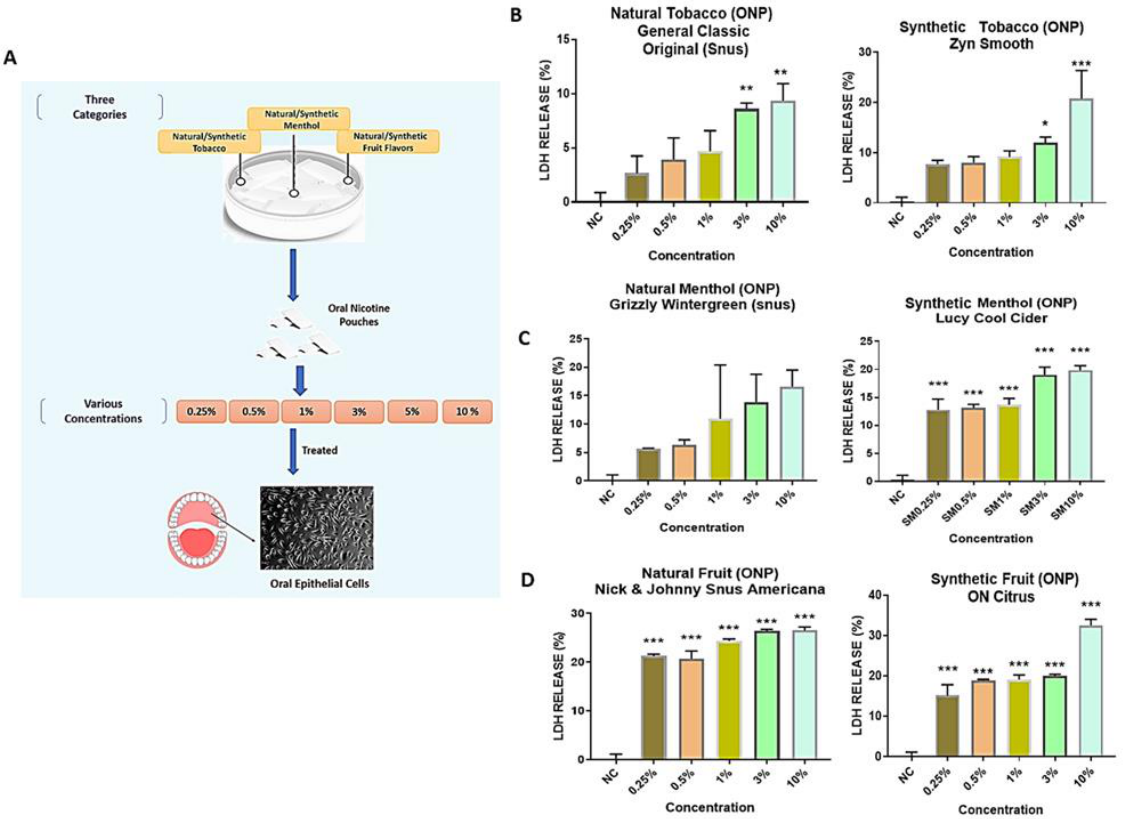
Figure 3. Differential cytotoxicity among oral epithelial cells upon treatment with different flavored oral smokeless nicotine products : ( A ) Diagrammatical representation of the experimental workflow. (B – D) Cytotoxicity Assay on oral epithelial cells: human gingival epithelium progenitors cells (HGEPp; gingival epithelial cells) were treated with different doses (0.25%, 0.5%, 1%, 3%, and 10%) of oral nicotine extracts categorizing natural/synthetic tobacco, menthol, and fruit flavors from different brands (Snus, Zyn, Grizzly, Lucy and ON). Followed by 24 h exposure, conditioned media were used for the lactate dehydrogenase (LDH) assay. Data represented as mean ± SEM, * p < 0.05, ** p < 0.01, *** p < 0.001 compared to control. n = 3. 3.1.2. Cytotoxicity of BEAS-2B Cells were Exposed to Different Concentrations of Ex- tracts Isolated from Spearmint-Flavored Snus (SKOAL) and ONPs (Zyn) BEAS-2B cells were exposed to different concentrations of extracts isolated from spearmint-flavored snus (SKOAL) and ONPs (Zyn). Subsequently, the cytotoxicity of the flavored nicotine ouches was assessed through collecting culture media exposed to 24 h of treatment with a respective extract. The untreated group was considered the control group. Among the tested spearmint products, minimal LDH release was observed at 0.05% concentration, whereas exposure to the 0.1% and 0.25% concentrations exhibited significant levels of LDH release ( p < 0.01) (Figure 4A)., Both the % LDH release values of BEAS-2B cells exposed to 0.05% Skoal spearmint extract and the 0.05% Zyn spearmint extract did not significantly differ from the corresponding control ( p > 0.05). Additionally, both the % LDH release values of BEAS- 2B cells exposed to 0.1% ( v / v ) Skoal spearmint extract and 0.1% ( v / v ) Zyn spearmint extract did significantly differ from the % of LDH released from the corresponding control (*** p < 0.001); similar results were seen amongst the 0.25% ( v / v ) spearmint-flavored oral nicotine pouch extracts. We further carried out other assays using 0.1% and 0.25% concentrations in light of these observations. Further- more, 16-HBE cells were individually exposed to 0.25% and 1% extracts of ON! original,